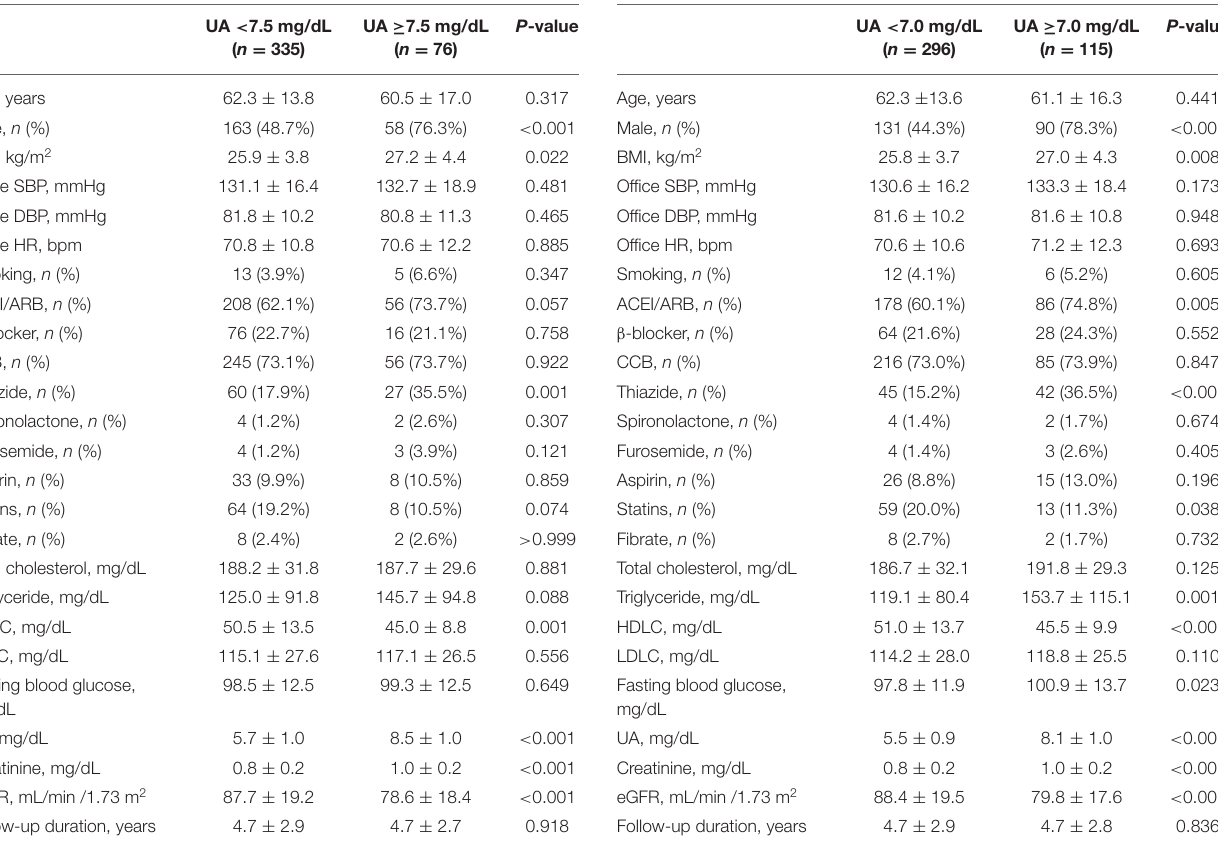
TABLE 3 | Baseline characteristics according to uric acid level ( ≥ 7.5 mg/dL). TABLE 4 | Baseline characteristics according to uric acid level ( ≥ 7.0 mg/dL).